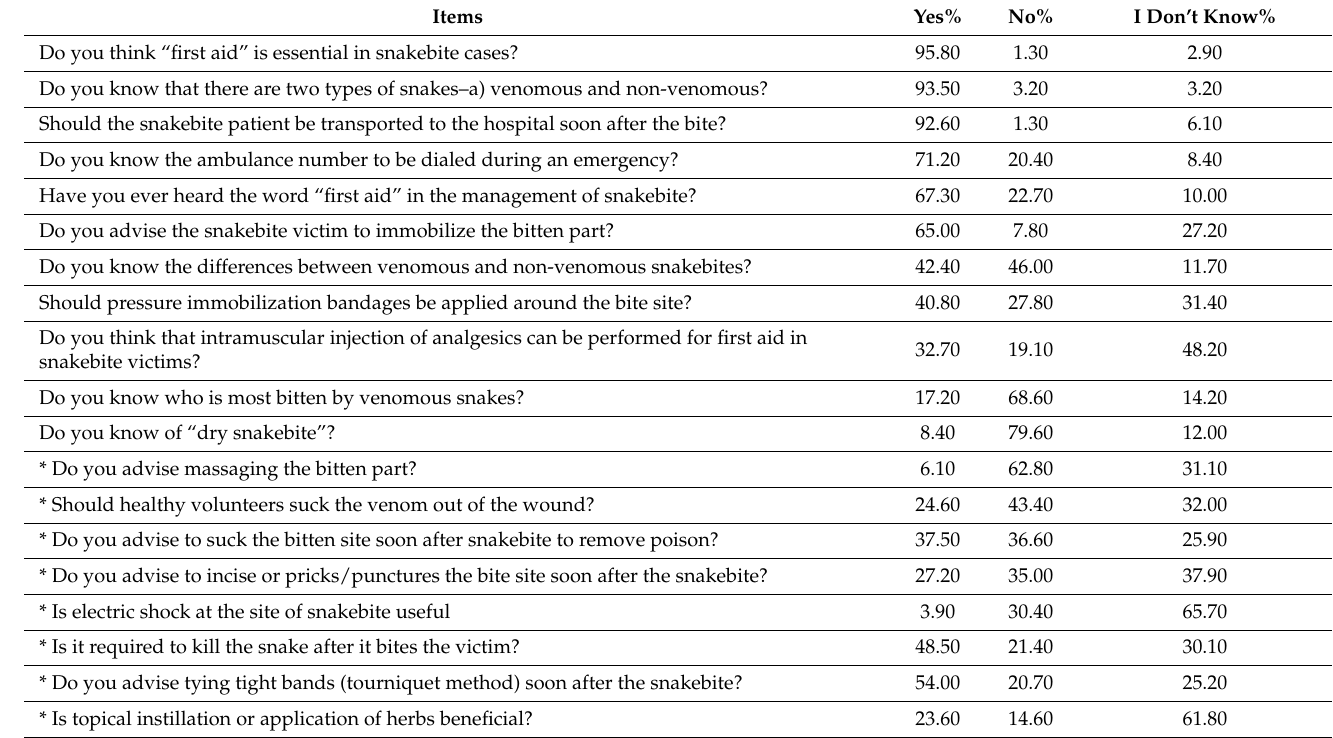
Table 3. Participants’ knowledge about snakebite first-aid